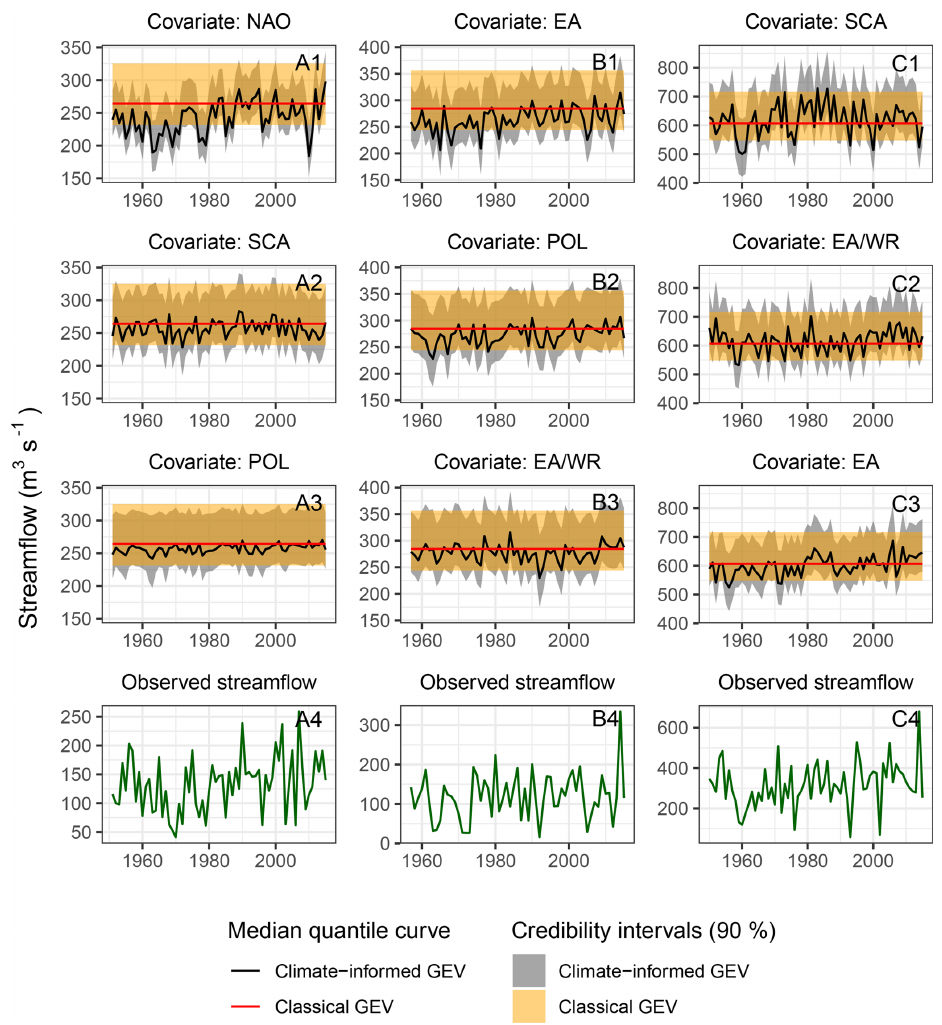
Figure 7. Annual maximum discharge time series (A4, B4, C4) and climate-informed quantiles (A1–A3, B1–B3, C1–C3) with credibility intervals for an exceedance probability of 0.02 and for three selected gauges (Tables 5 and 6). Climate-informed quantiles are compared with those of the classical GEV distribution. The three best climate-informed models based on the DIC are shown for each site, with increasing DIC from top to